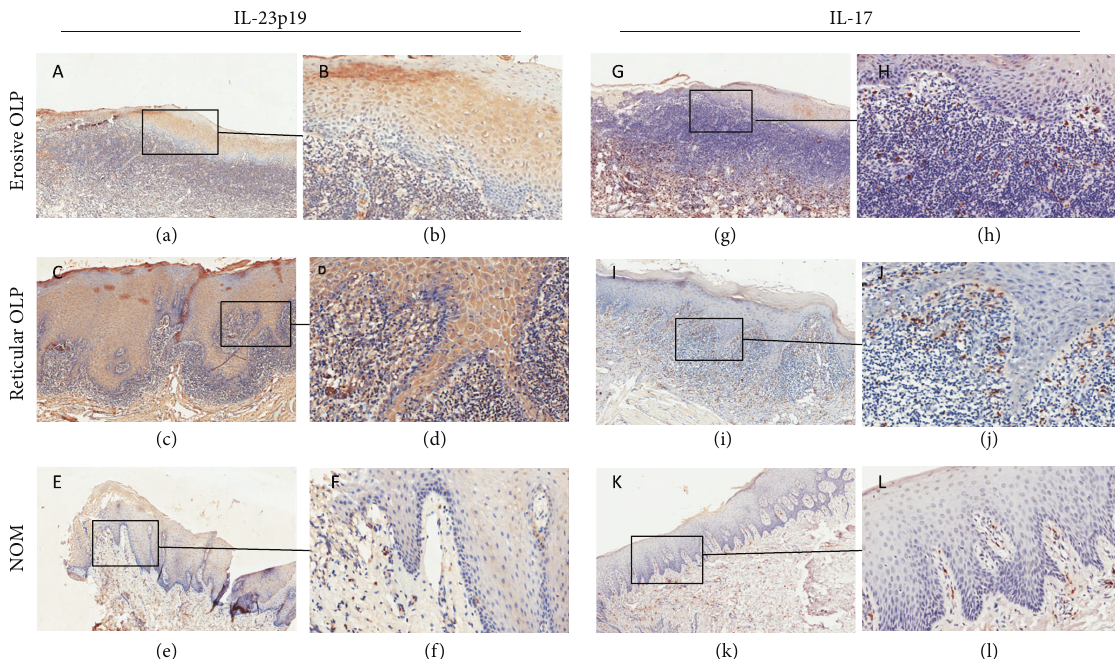
Figure 1: Immunohistochemical stainings for IL-23p19 (a–f) and IL-17 (g–l) in erosive (a, b, g, and h) and reticular (c, d, i, and j) OLP lesions and normal oral mucosa tissues (e, f, k, and l). Immunohistochemical staining for IL-23p19 showed diffuse and strong patterns in epithelium and the extracellular matrix of the lamina propria of both erosive ((a) × 100; (b) × 400) and reticular ((c) × 100; (d) × 400) OLP lesions, but weak or absent pattern in normal oral mucosa tissues ((e) × 100; (f) × 400). Abundant IL-17 positive staining was observed on the cytoplasm of the infiltrated lymphocytes in the lesions of both erosive ((g) × 100; (h) × 400) and reticular ((i) × 100; (j) × 400) OLP, but only a few sporadic IL-17+ cells were seen in normal oral mucosa ((k) × 100; (l) ×